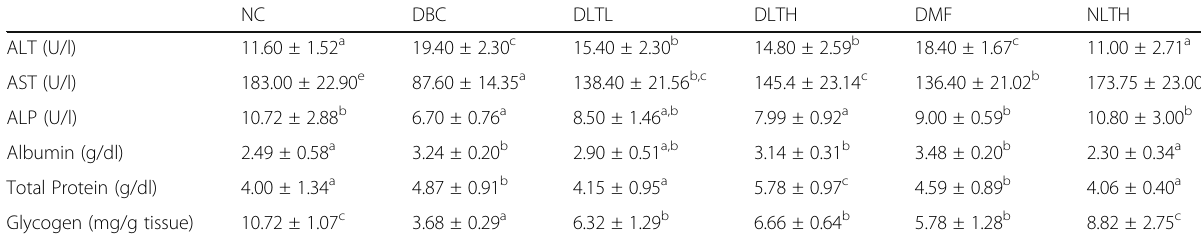
Table 3 Serum biochemical parameters and liver glycogen content of type 2 diabetic rats given lemongrass tea ad libitum